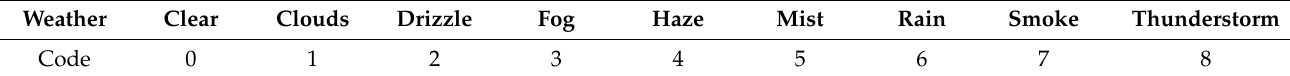
Table 1. Numerical coding of weather data.